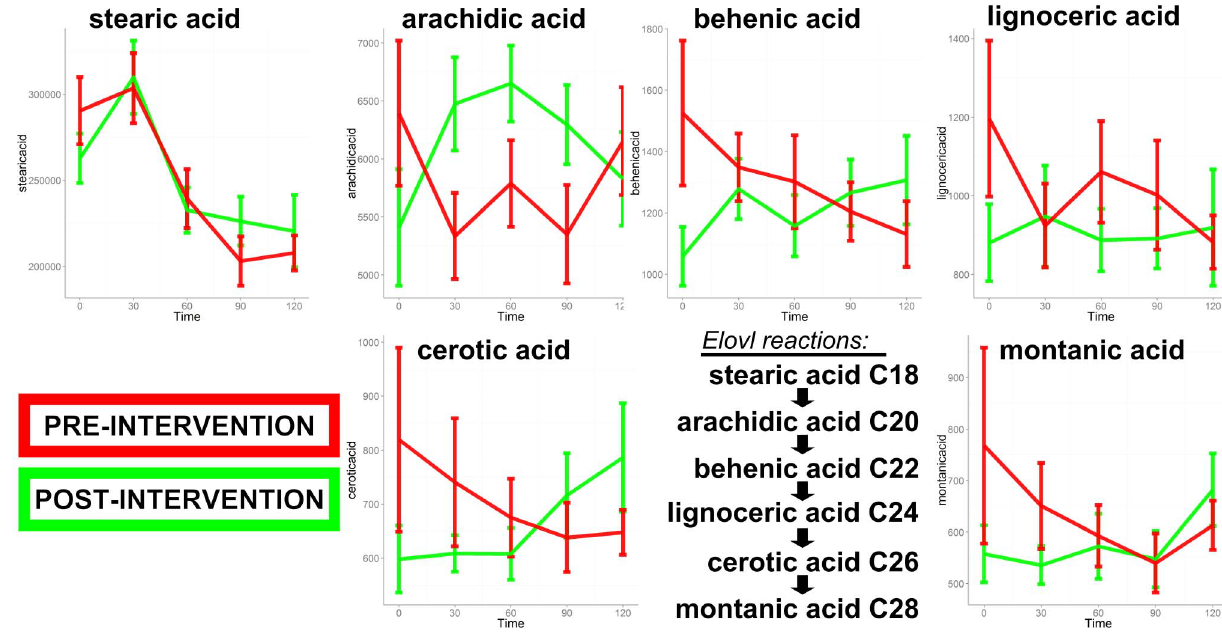
Figure 5. Post-OGTT excursions in plasma concentrations of very long chain fatty acid (VLCFA) metabolites that are products of the Elongation of very long chain fatty acid (Elovl) enzymes. Illustrated are temporal changes in metabolites when comparing the pre- and post- intervention phases (red and green lines, respectively) of a weight loss and fitness regimen in women. Values are quantion peak heights for each of the individual metabolites. Also shown is the set of reactions catalyzed by ELOVL including metabolites detected in this study.